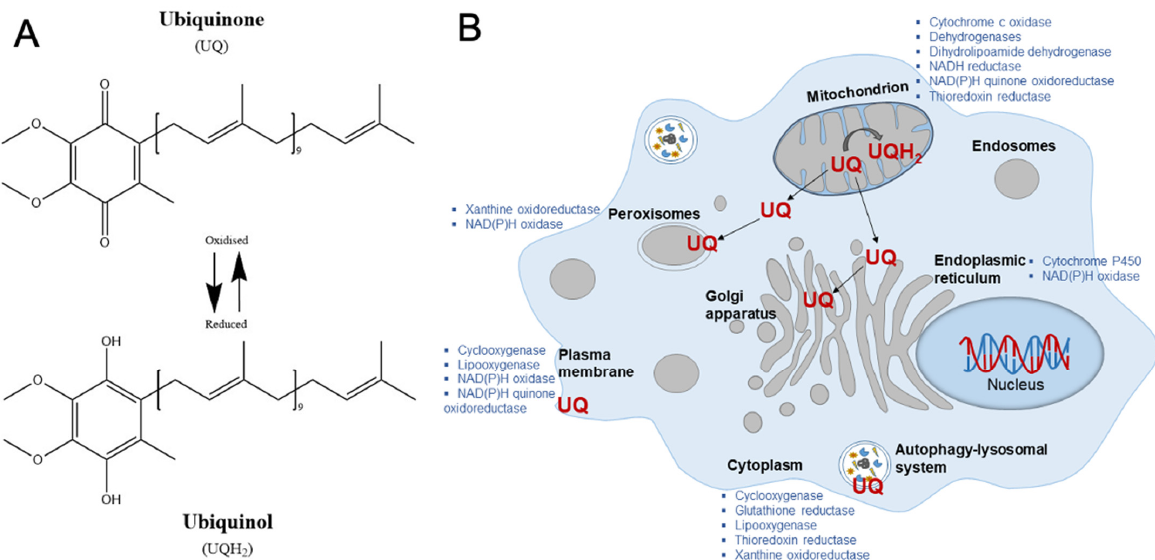
Figure 2. Chemical structure and biological functions of CoQ 10 . ( A ) Enzymatic conversion of coenzyme-Q 10 from oxidized Ubiquinone (UQ) to reduced Ubiquinol (UQH2) form that is crucial for enzymatic activities of multiple cellular oxidoreductases (depicted in ( B )). ( B ) Schematic representation of cellular and subcellular organelles indicating enzymatic complexes using CoQ 10 conversion for their activities ( A ).